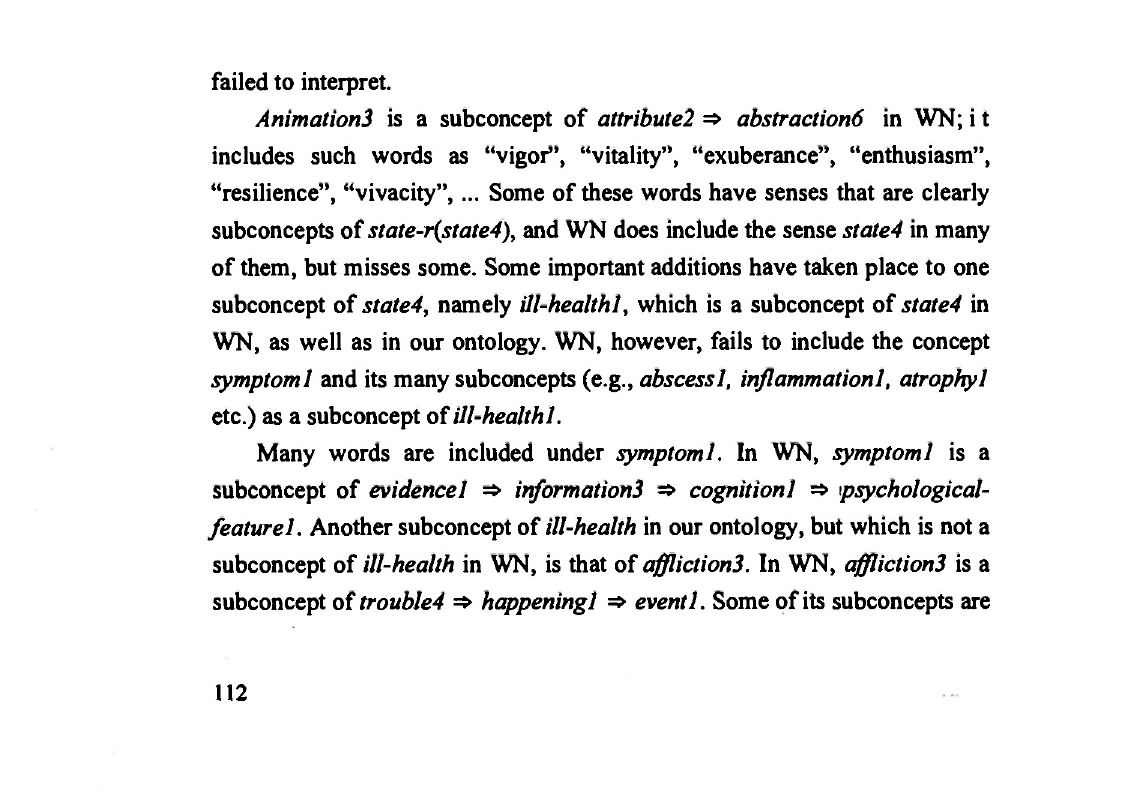
Fig. 3: Hierarchy for the concepts of action state-r, event, process, phenomenon